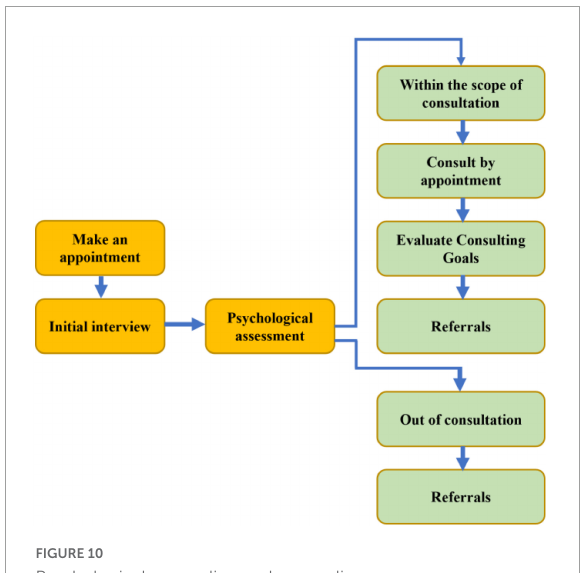
FIGURE10 Psychological counseling and counseling